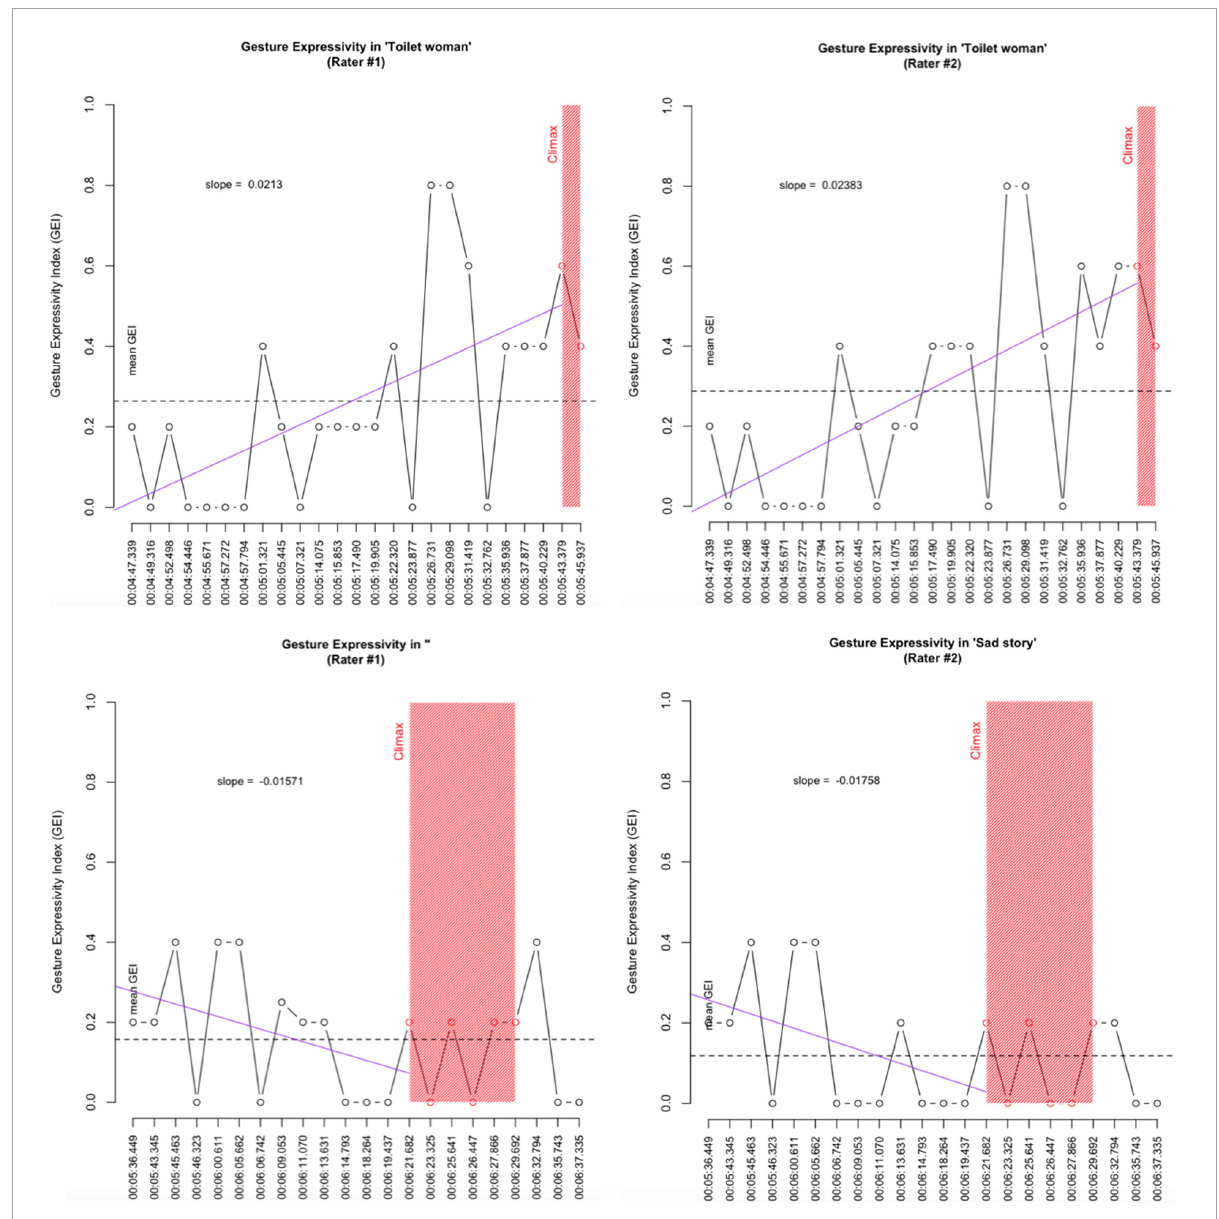
FIGURE11 Gesture Expressivity in “Toilet woman” vs. “Sad story”. Dashed line: mean Gesture Expressivity Index. Solid pink line: regression (‘trend’) line computed from story beginning to Climax onset.